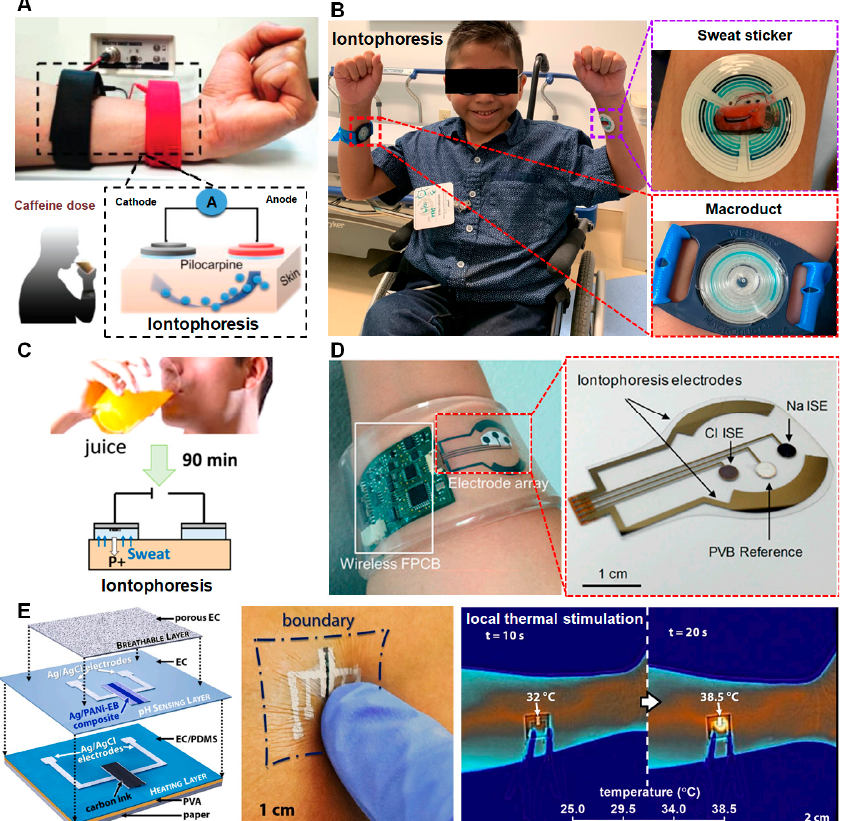
Figure 3. Epidermal wearable biosensors for active sweat extraction through iontophoresis stimulation ( A – D ) and local thermal stimulation ( E ). ( A ) Schematic of sweat stimulation by iontophoresis delivery of pilocarpine and caffeine monitoring (Reprinted with permission from Ref. [58]. Copyright 2018, John Wiley and Sons). (B) Based on iontophoresis sweat extraction, a pediatric subject’s sweat Cl − was monitored for a cystic fibrosis diagnosis (Reprinted with permission from Ref. [98]. Copyright 2021, The American Association for the Advancement of Science). ( C ) Schematic of the epidermal biosensor for sweat vitamin C monitoring based on iontophoresis sweat extraction (Reprinted with permission from Ref. [40]. Copyright 2020, American Chemical Society). ( D ) Iontophoresis electrode and sweat sensor electrode [97]. ( E ) Electronic decal containing a heating layer to apply localized heat stress on the skin for rapid sweat production (Reprinted with permission from Ref. [93].